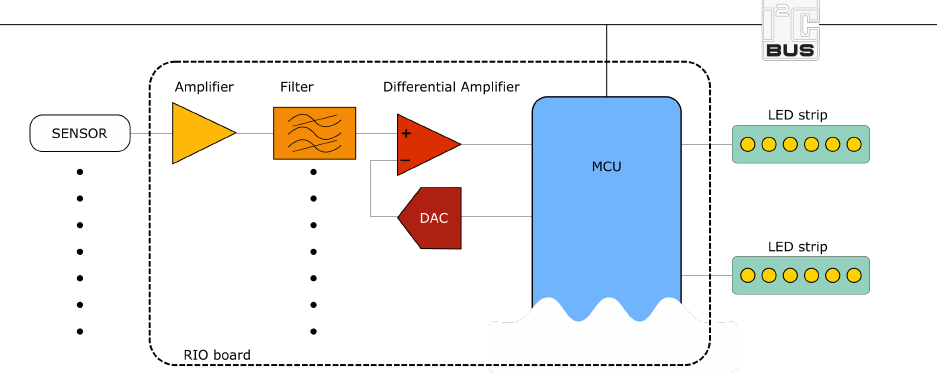
Figure 3. Block diagram of the RIO